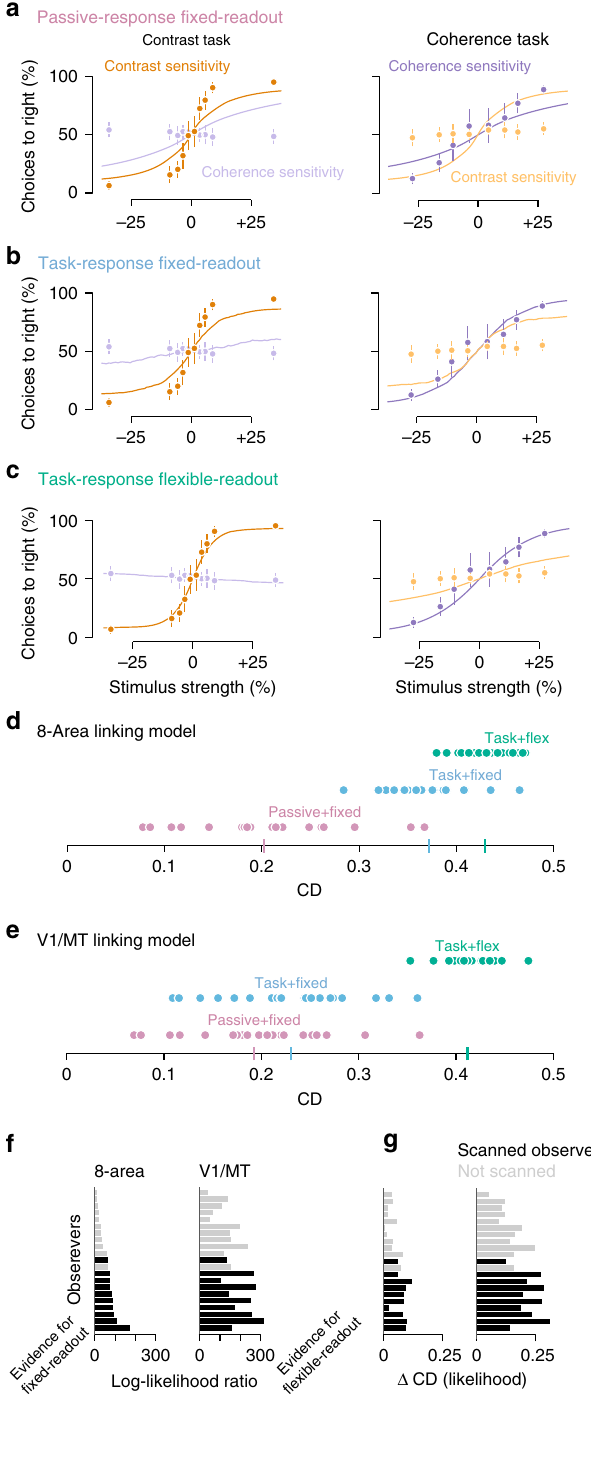
the cortical readout weights for the contrast task (from Eq. 7: β V1, β … ) and vice versa. This model underestimated human V2 , performance on catch trials (dashed lines, Fig. 8). On contrast catch trials (i.e., post-cued trials when observers reported about contrast, during a run where the main task was coherence), the model predicted JND of 56.9%, 95% CI [33.8, 80.1], but the average observer had a JND of only 10.1% contrast, 95% CI [7.5, 12.7]. On coherence catch trials, the model predicted that NATURE COMMUNICATIONS| (2019) 10:3500